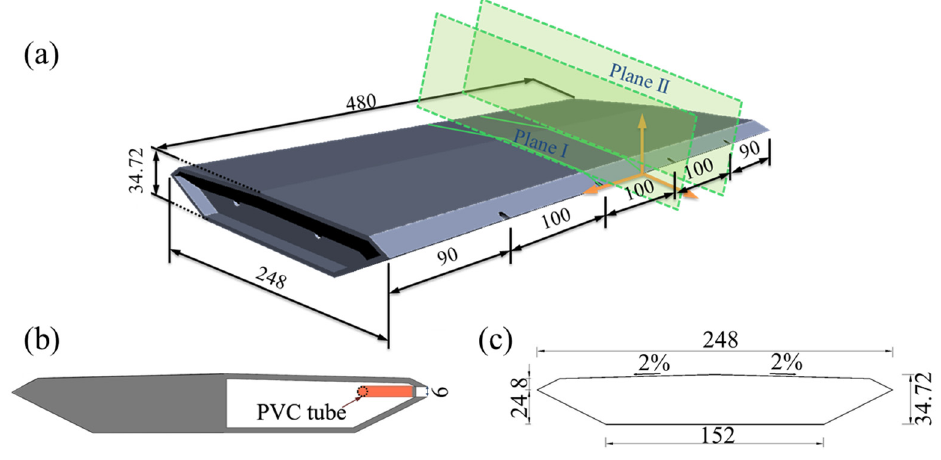
Figure 1. The geometric scale of the present test model (unit: mm). ( a ) The three-dimension view, ( b ) cross-section in plane I, ( c ) cross-section in plane II.